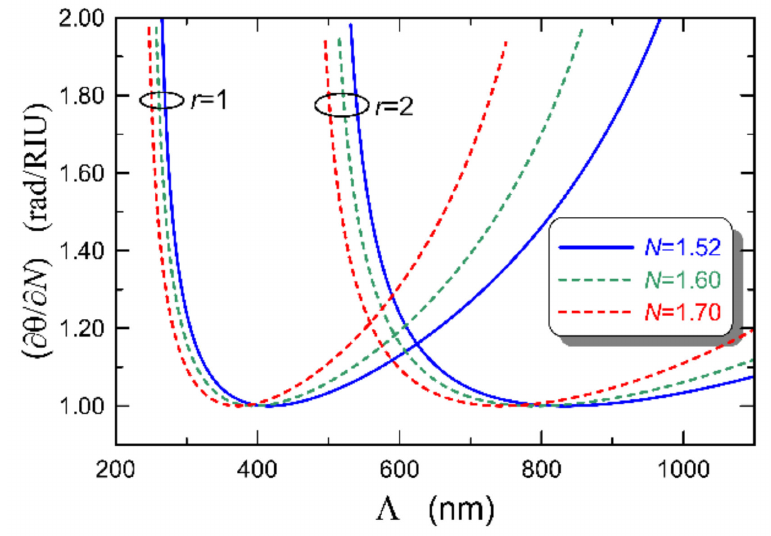
Figure 4. Calculated sensitivity of the resonance coupling angle with respect to a period of the grating coupler for three different values of the effective index and for wavelength λ = 632.8